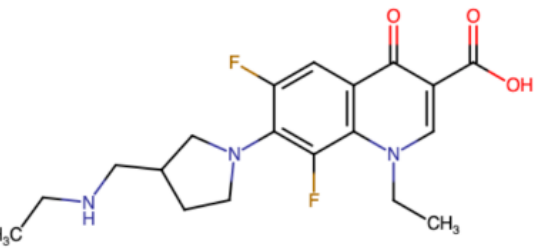
Figure 5. Cartoon structure of merafloxacin [165], an inhibitor of SARS ‐ CoV ‐ 2 frameshifting